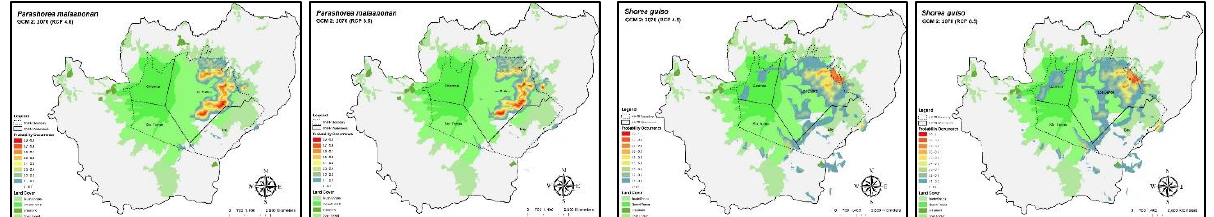
Figure 9. Predicted distribution of Parashorea malaanonan (L) and Shorea guiso (R) for GCM-2 by year 2070 under RCP 4.5 and RCP